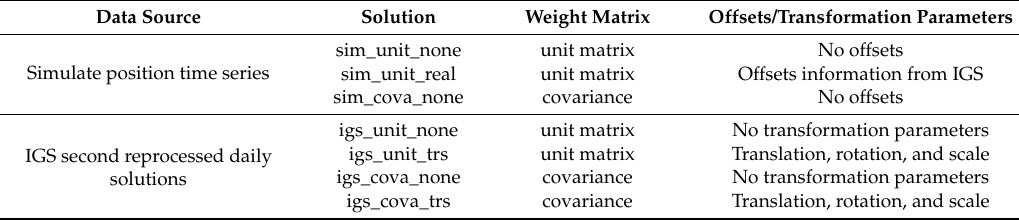
Table 1. Cumulative solutions with different processing strategies for noise analyses. For the solutions with different labels, “sim” and “igs” mean the data sources, “sim” for simulated and “igs” for real IGS position time series; “unit” and “cova” mean the weight matrix used for cumulative solutions, “unit” stands for unit or identity matrix and “cova” means full weight matrix derived from the covariance information in the IGS daily solutions. For cumulative solutions using the simulated time series, the “real” and “none” mean offsets parameterized or not, respectively, in the functional model. For cumulative solutions using the real time series, where the “trs” and “none” mean transformation parameters estimated or not,